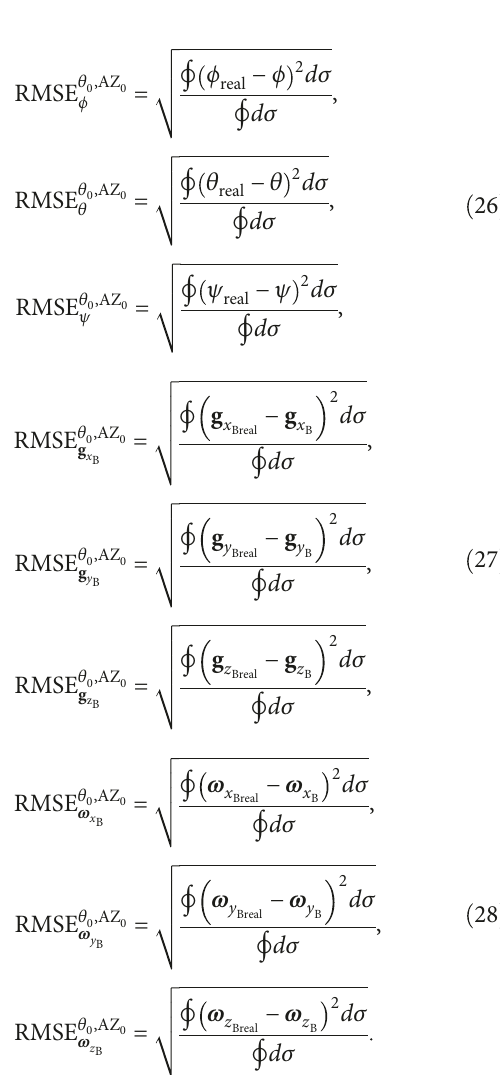
Figure 1: Trajectories for initial pitch shot angles of 15 ° , 45, ° and 75 ° and 8 di ff erent